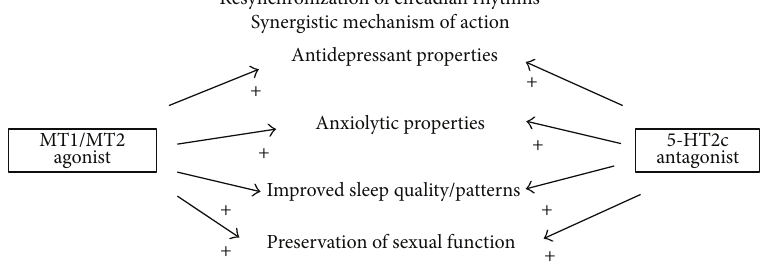
Figure 1: Mechanism of action of